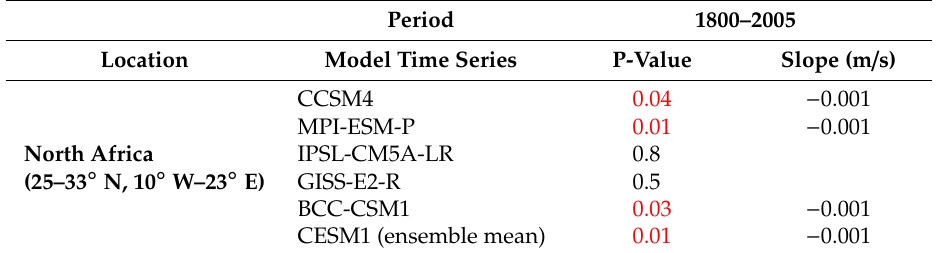
Table 5. Results of modified Mann–Kendall test of U850 trend detection for six PMIP3/CMIP5 model simulations over 850–1800 and 1800–2005 in North Africa. (Red indicates significance, with a p-value <0.05.).